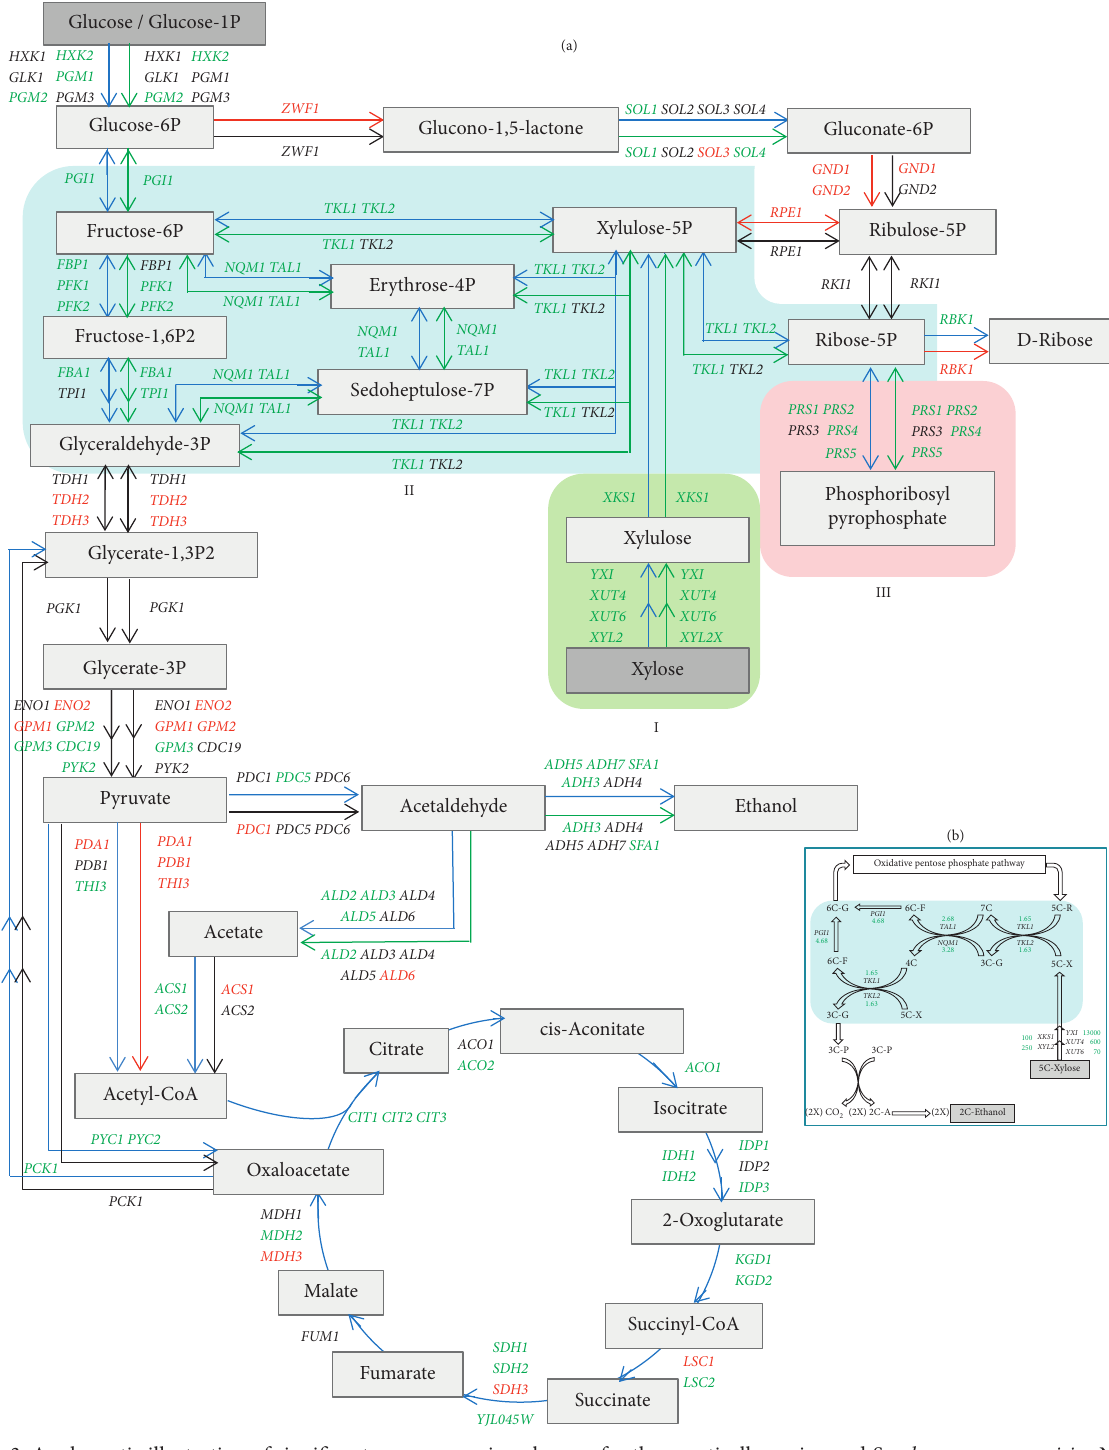
Figure 3: A schematic illustration of significant gene expression changes for the genetically engineered Saccharomyces cerevisiae NRRL Y- 50463 compared with its parental wild-type industrial strain NRRL Y-12632 for endogenous genes involved in glycolysis, pentose phosphate pathway, and TCA cycle at 24h using xylose as the sole source of carbon when glucose was depleted. The arrows on the left and the top from the parallel lines represent aerobic growth condition and those on the right side or at the bottom represent oxygen-limited fermentation condition. The blue- or green-colored arrows indicate significantly greater gene expression for aerobic and oxygen-limited conditions, respectively. The arrows in red indicate repressed expression, and the arrows in black indicate gene expression at normal or nearly normal levels. Elements of the signature expression for strain NRRL Y-50463 were boxed in various colors and labeled I, II, and III (A). An illustration of xylose transformation and metabolism through the nonoxidative pentose phosphate pathway for the genetically engineered industrial yeast Saccharomyces cerevisiae NRRL Y-50463. 2C-A stands for acetaldehyde; 3C-G, glyceraldehydes 3-phosphate; 3C-P, py- ruvate; 4C, erythrose 4-phosphate; 5C-R, ribose 5-phosphate; 5C-X, xylulose 5-phosphate; 6C-F, fructose 6-phosphate; 6C-G, glucose 6- phosphate; and 7C, sedoheptulose 7-phosphate. Expression fold changes against the wild-type control at 24 h are presented in green (B)